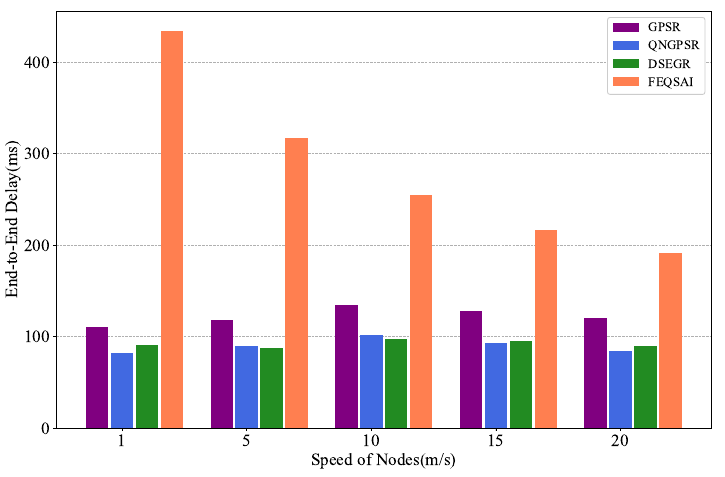
Figure 5. Performance comparison of the end-to-end delay among GPSR, QNGPSR, DSEGR, and FEQSAI with different node movement